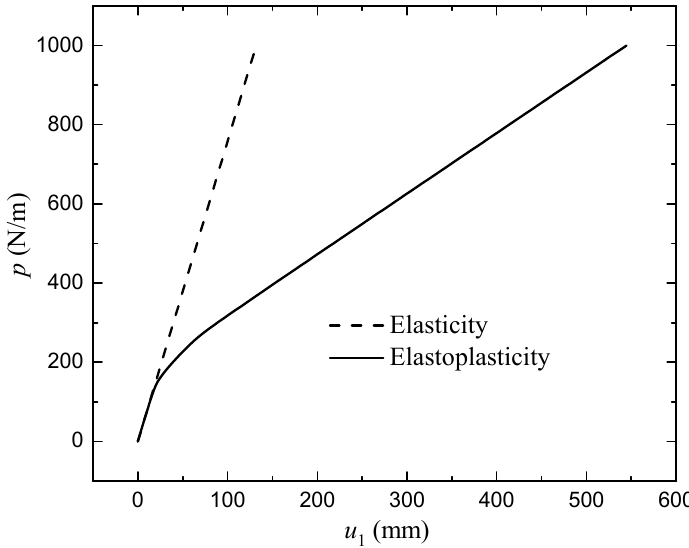
Figure 16. The relation between the displacement and traction.